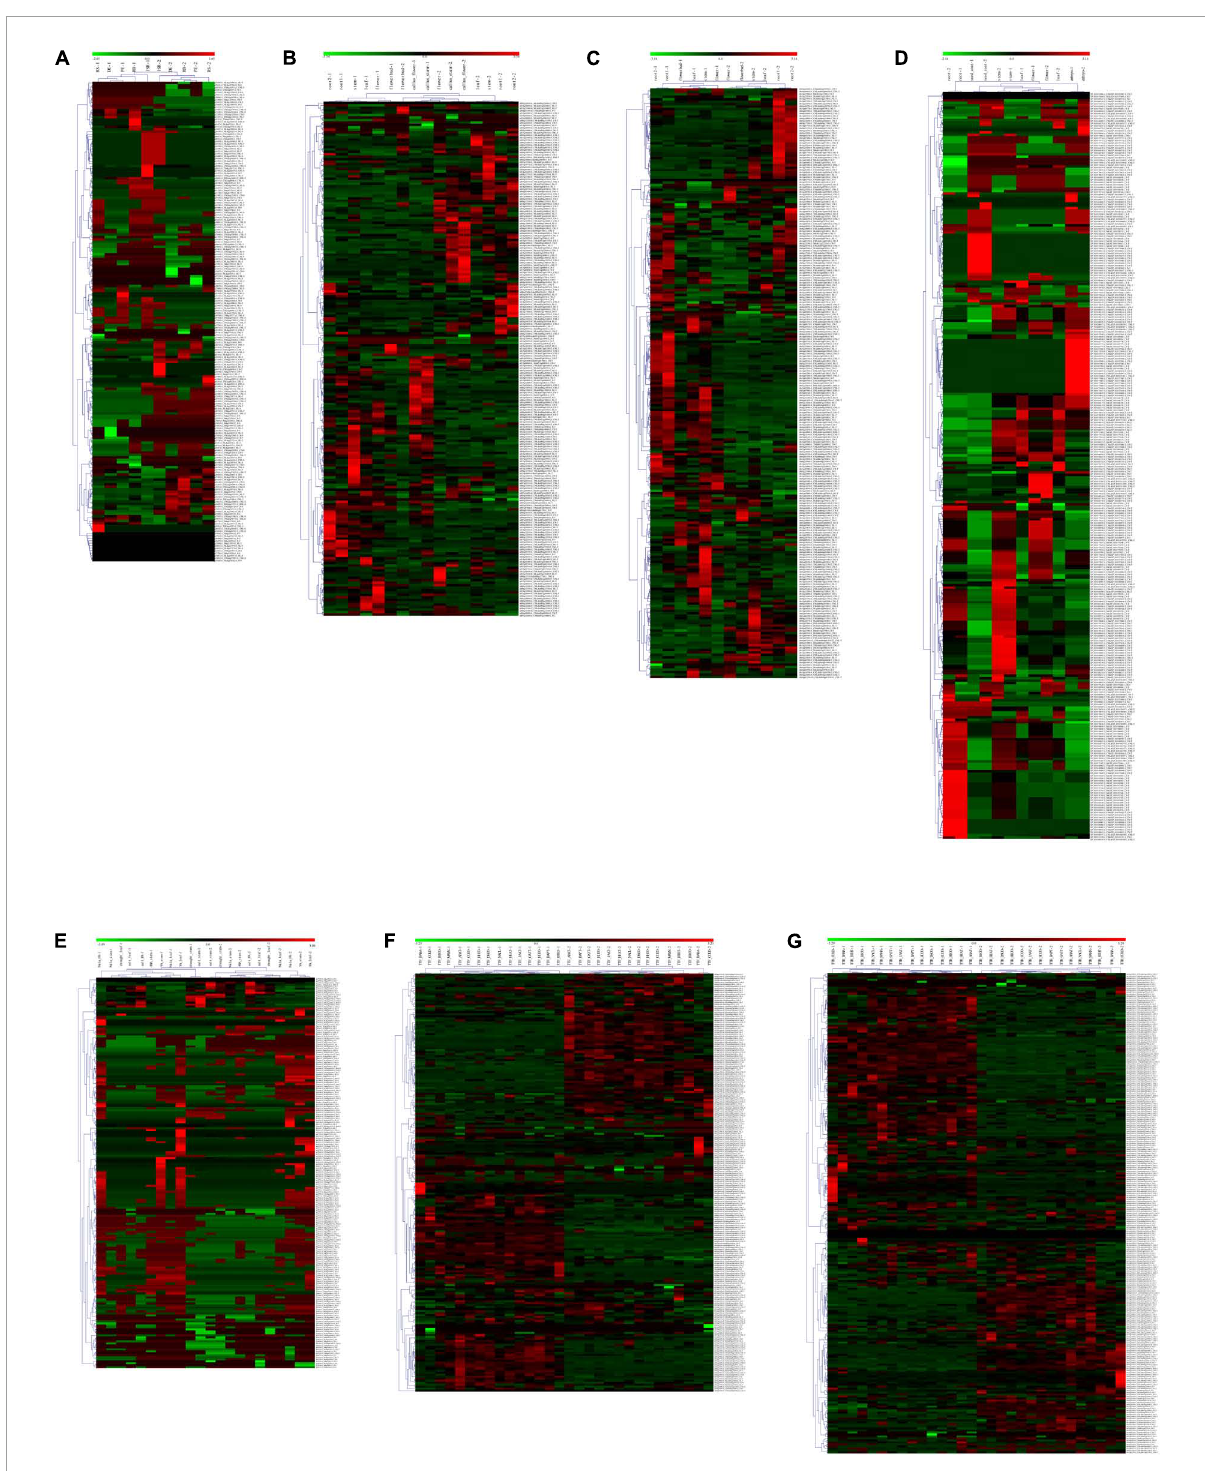
FIGURE6 Heatmap of the compared expression profiles of duplicated nucleotide-binding site (NBS)-encoding genes in the four Ipomoea species. The heatmap for duplicated NBS-encoding gene pair was named as “gene1” + “ & ” + “gene2” + “duplicated patterns (-S: segmental duplication; -T: tandem duplication)” (gene1 and gene2 were duplicated gene pairs). For each tissue or stress: “-1” indicates the heatmap of “gene1”; “-2” indicates the heatmap of “gene2.” (A) Expression profiles of duplicated NBS-encoding genes in different sweet potato tissues: initiative storage root (ISR), distal end (DE), proximal end (PE), root body (RB), and root stalk (RS). (B) Expression profiles of duplicated NBS-encoding genes in different I. trifida tissues: the callus flower, callus stem, flower, flower bud, root 1, root 2, leaf, and stem. (C) Expression profiles of duplicated NBS-encoding genes in different I. triloba tissues: root 1, root 2, flower, flower bud, leaf, and stem. (D) Expression profiles of NBS-encoding